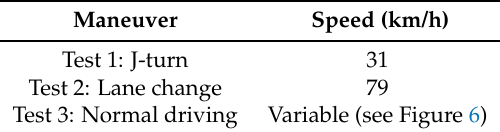
Table 6. Vehicle speed for